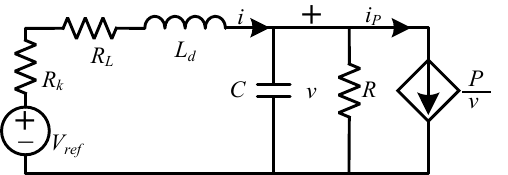
Figure 5. Equivalent circuit model of DC microgrid